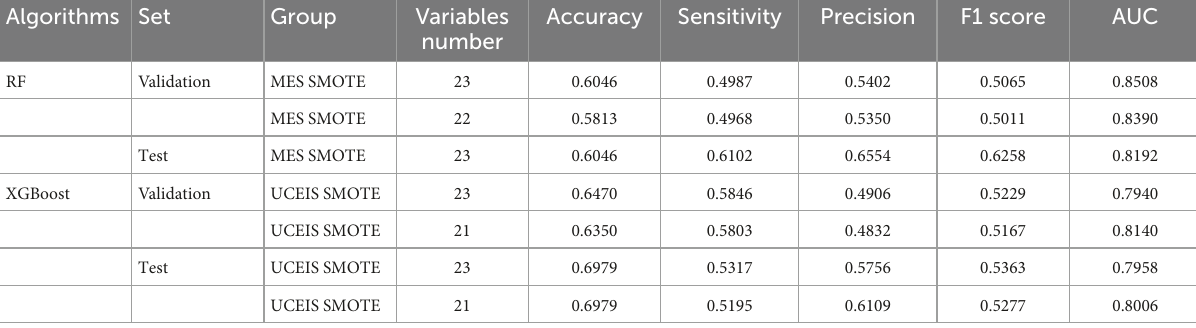
TABLE 3 The best performance of the models in the validation set and test set. Algorithms Set Group Variables